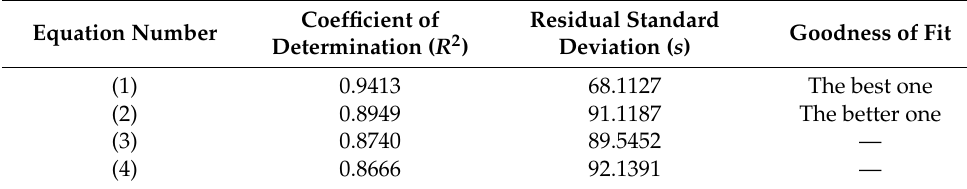
Table 3. The goodness of fit of the regression equations a .